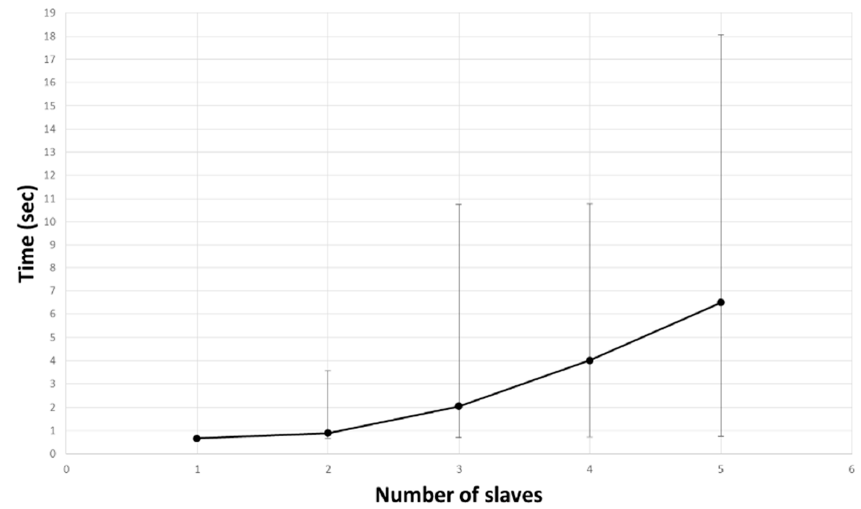
Figure 22. Elapsed time to organize a network, according to the number of slaves.